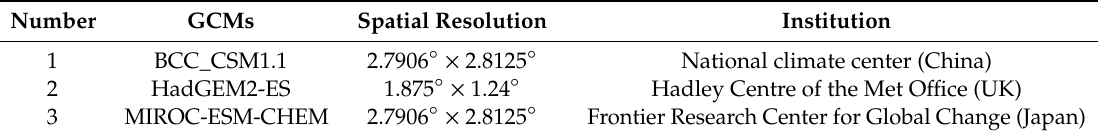
Table 1. Basic information on GCMs (General Circulation